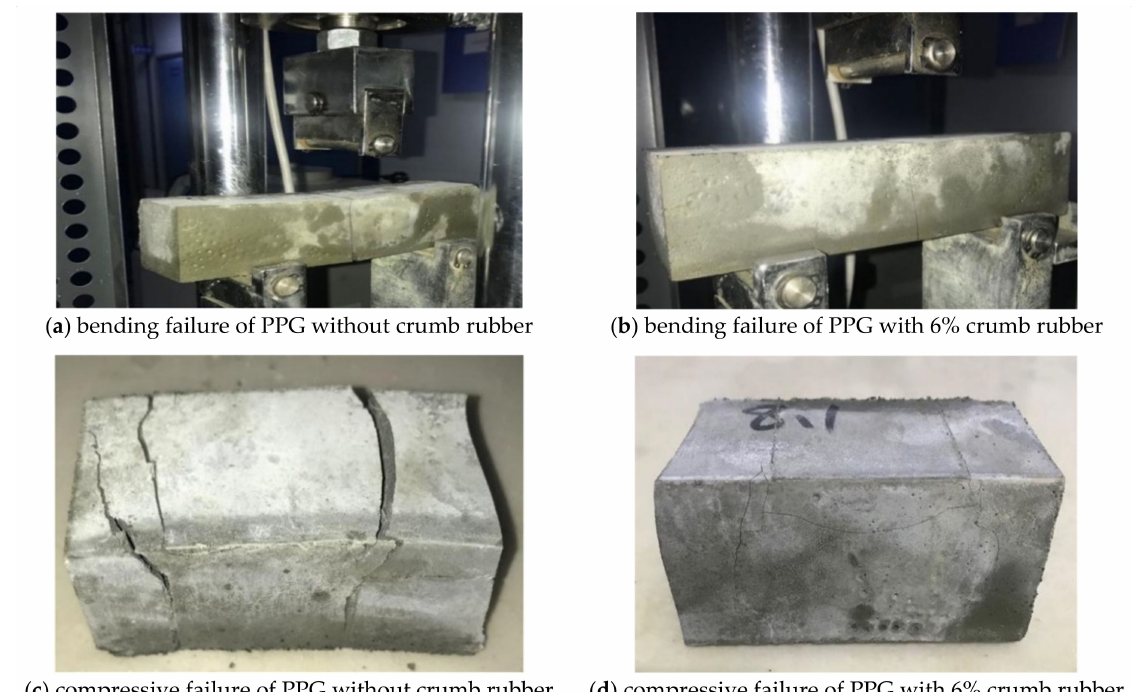
Figure 1. Comparison diagram of the damage of